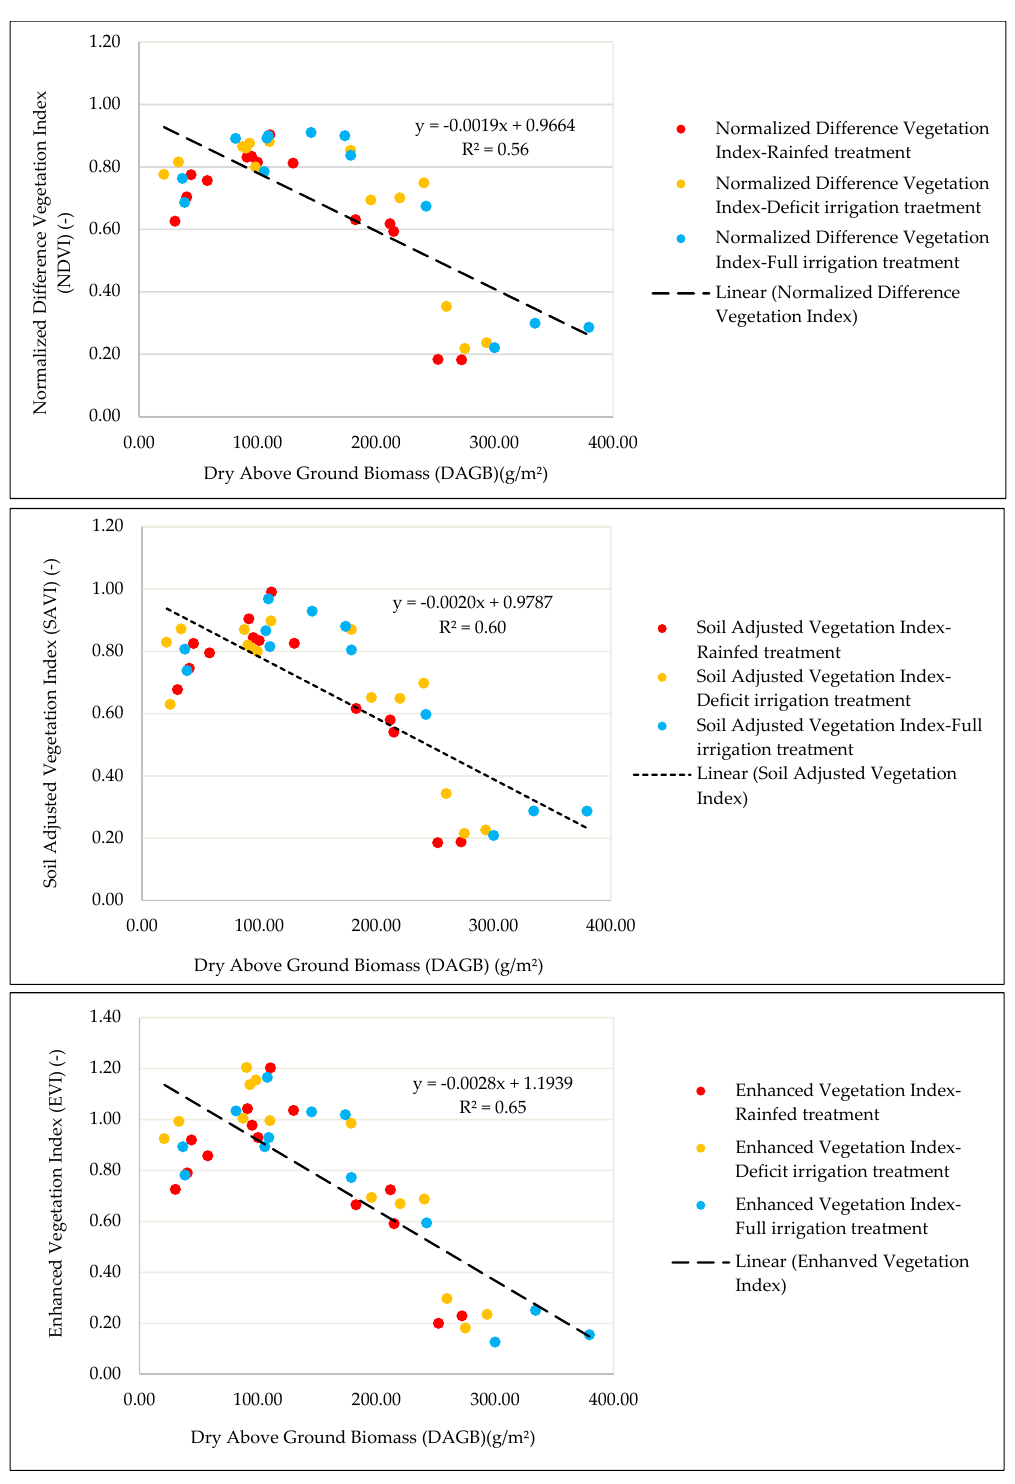
Figure 4. Linear regression parameters between the crop biometric parameters leaf area index and dry aboveground biomass and the spectral vegetation indices (NDVI, SAVI, and EVI).